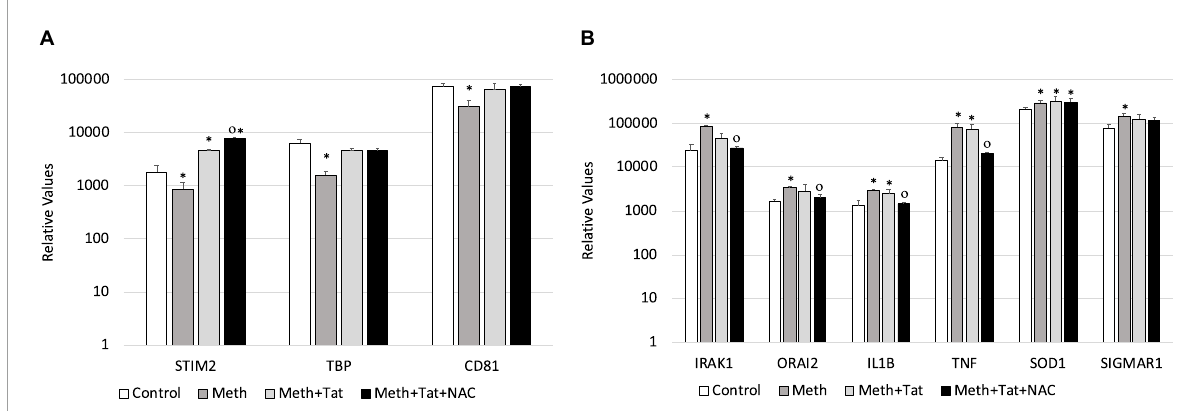
FIGURE6 Transcriptional changes that are induced by Tat in the context of Meth are both ROS-dependent and ROS-independent. The ROS-dependent effects of Tat on gene transcription, in the context of Meth, were tested by qRT-PCR in cultures that were treated with Meth, Tat and with NAC, 2 h after treatments. (A) Transcription of genes with RNAPol activity decreased by Meth and reverted by Tat, with no effect of NAC in the context of Tat. (B) Transcription of genes with RNAPol activity increased by Meth with partial or no effects of Tat, but reverted by NAC in the context of Tat. Tat (10 ng/ml) and NAC (1 uM) were evaluated in the same genes. *p < 0.05 compared to control. O p < 0.05 compared to Meth +